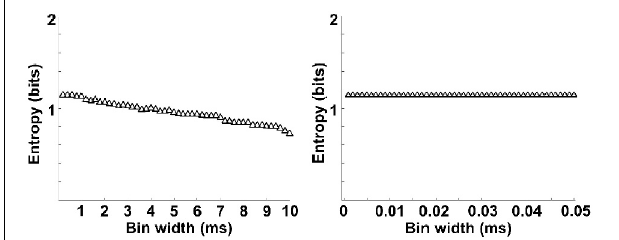
FIGURE 6 | Entropy estimation of spikes as a function of bin widths. Entropy varies with bin size (left). The data is linearly extrapolated to the point that bin size is zero (right). Entropy values decreased slightly with the increasing bin size and entropy values did not change when the bin sizes < 0.5ms.